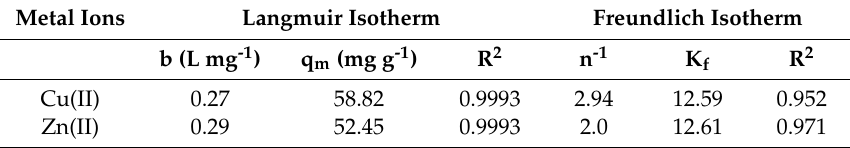
Table 3. Langmuir and Freundlich isotherm constants for the sorption of Cu(II) and Zn(II) on EPS. Metal Ions Langmuir